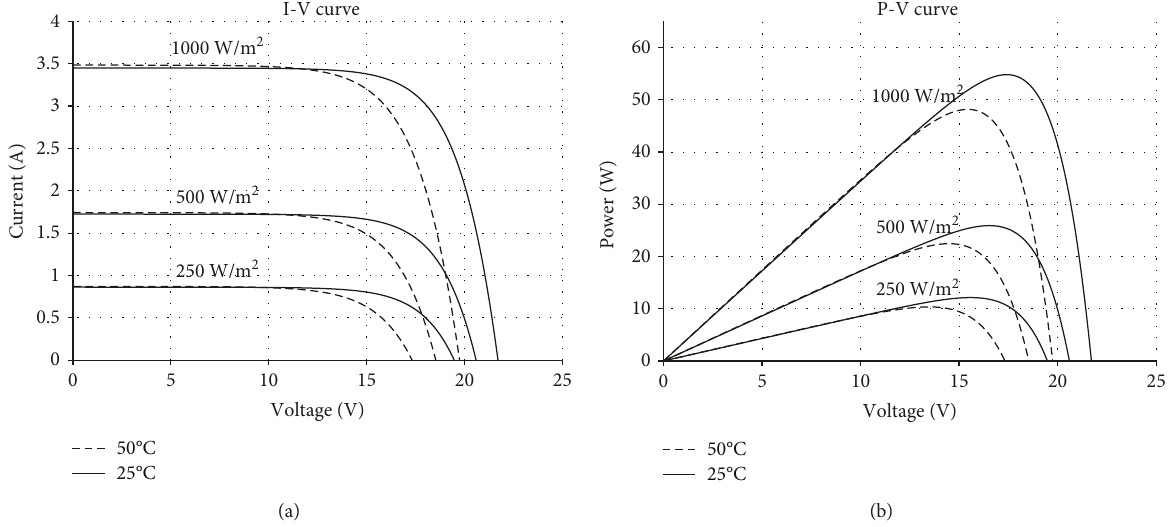
Figure 3: I-V (a) and P-V (b) characteristics of the Mono-Si PV panel SM55 for di ff erent levels of irradiance and temperature.